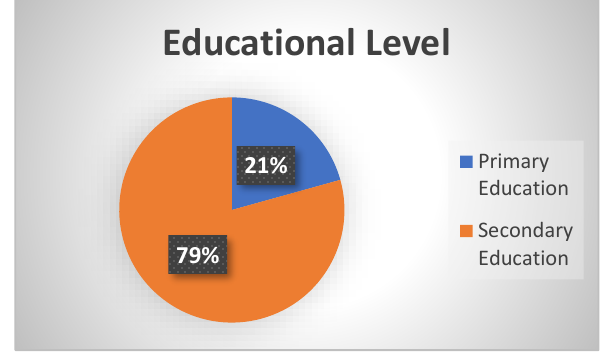
Figure 22. Educational level of the 58 school students.